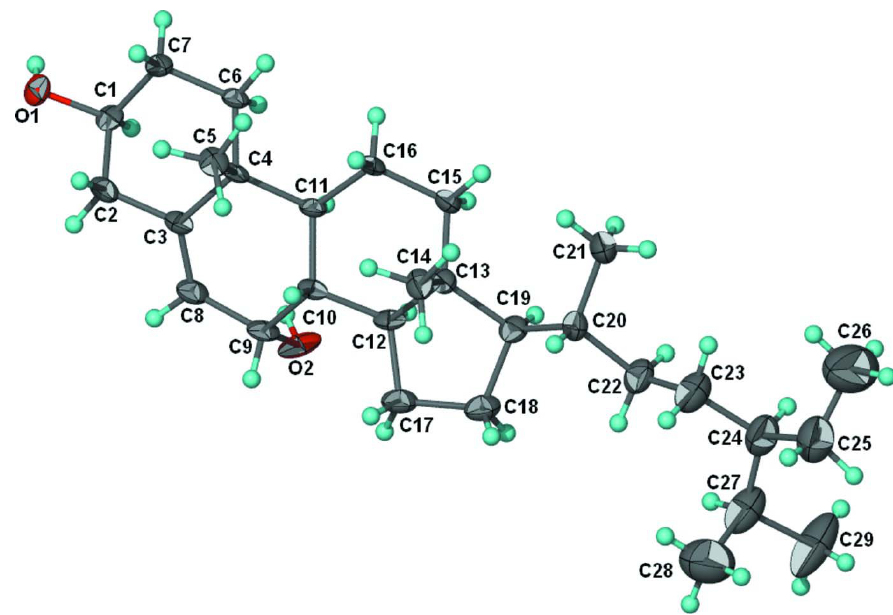
Figure 1 70% Probability displacement ellipsoid plot (Barbour, 2001) of C arbitrary